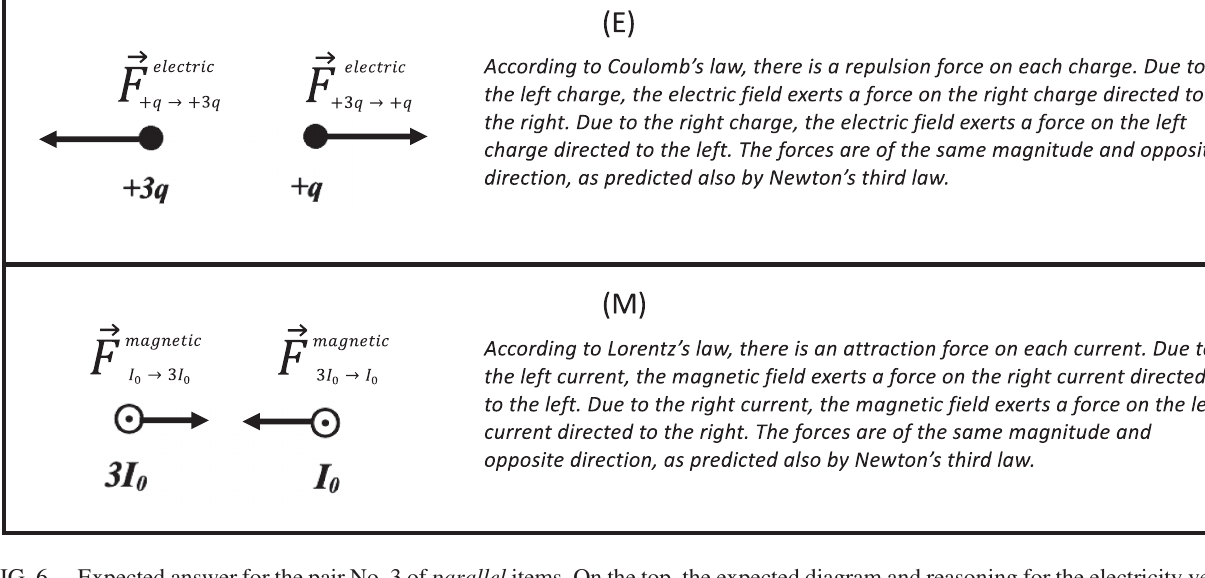
FIG. 6. Expected answer for the pair No. 3 of parallel items. On the top, the expected diagram and reasoning for the electricity version ( E ); on the bottom, the expected diagram and reasoning for the magnetism version ( M